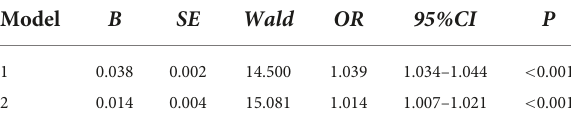
TABLE 2 Logistic regression analysis of TyG-BMI and NSCLC